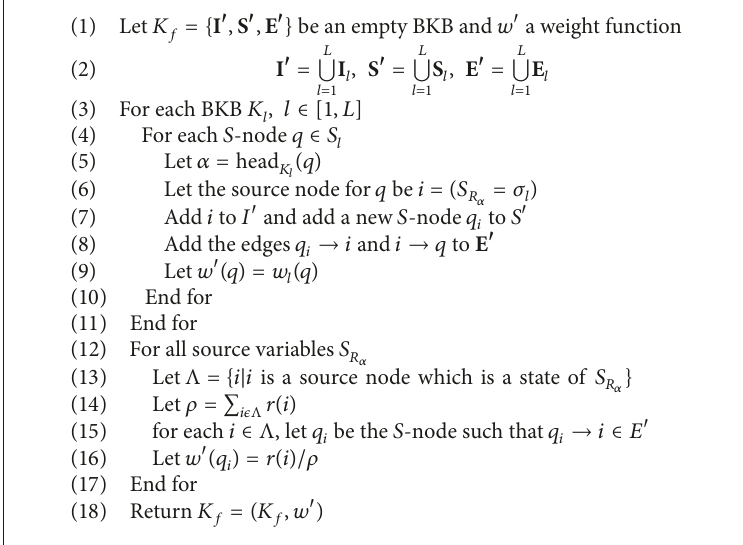
Algorithm 3: BKB fusion algorithm (Santos et al.